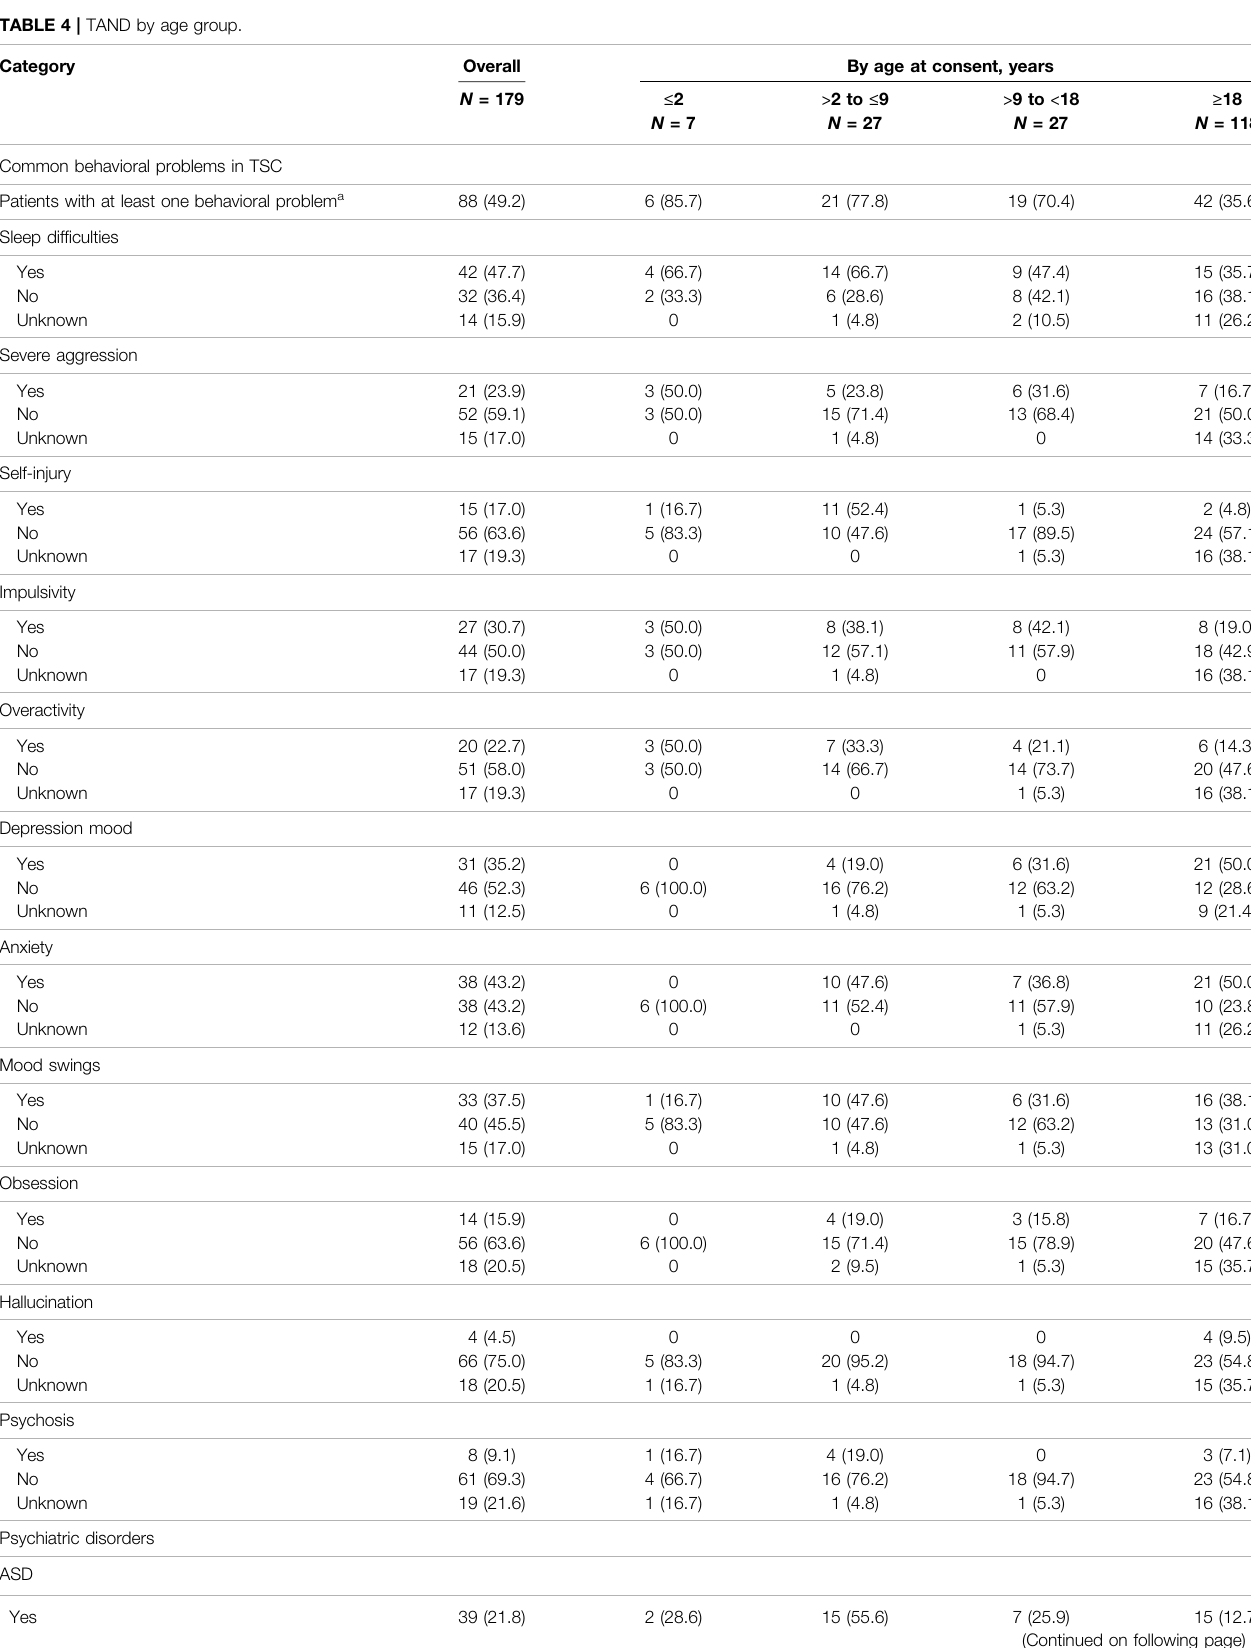
TABLE 4 | TAND by age